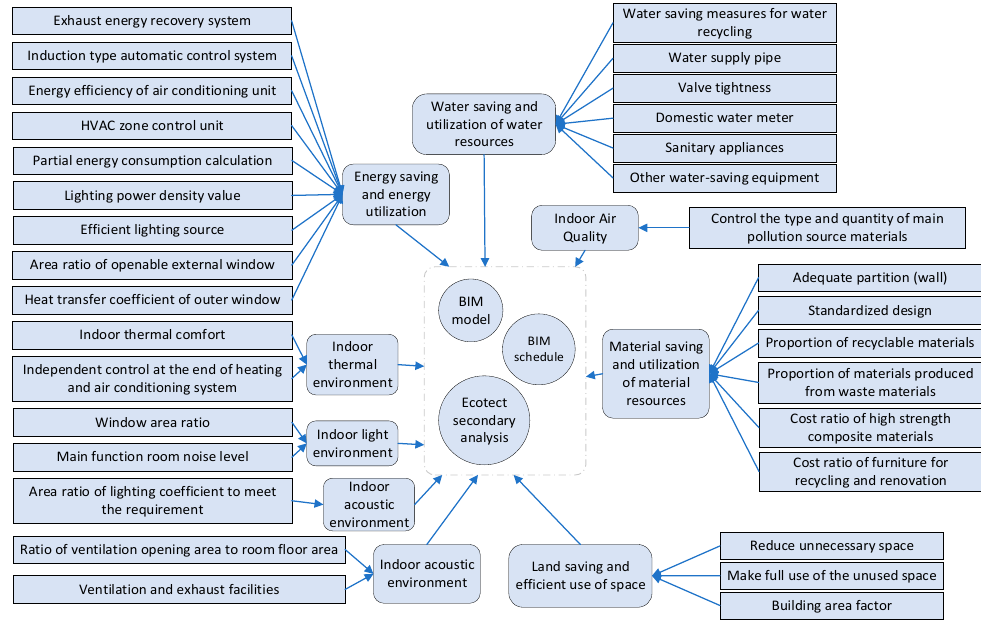
Figure 1. Scoring method for building interior decoration based on green evaluation standards.